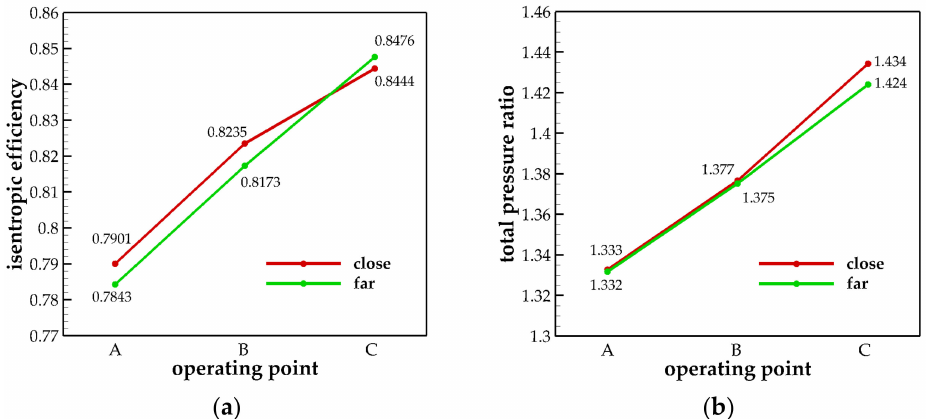
Figure 8. Time-averaged performance of the research compressor. ( a ) Isentropic Efficiency. ( b ) Total Pressure Ratio.